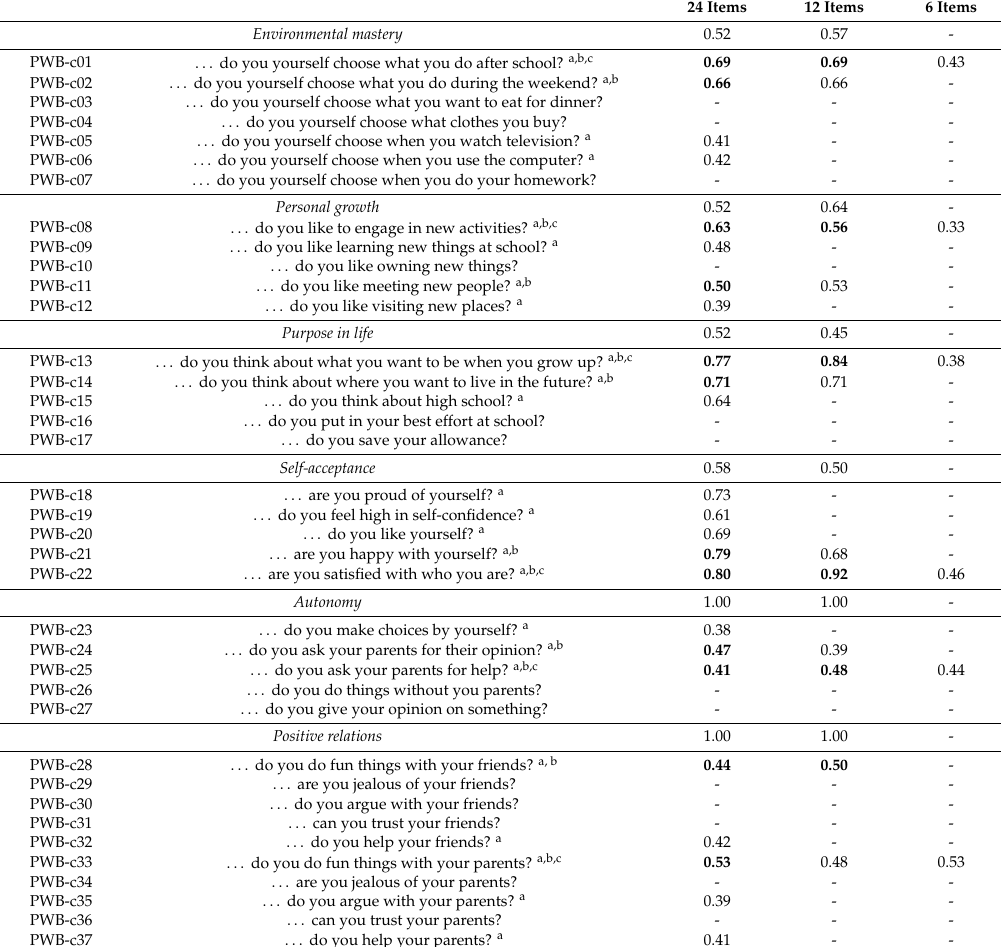
Table A1. List of items included the psychological well-being scale for children (‘how often . . . ’), and their accompanying standardized factor loading (Pilot study, N =